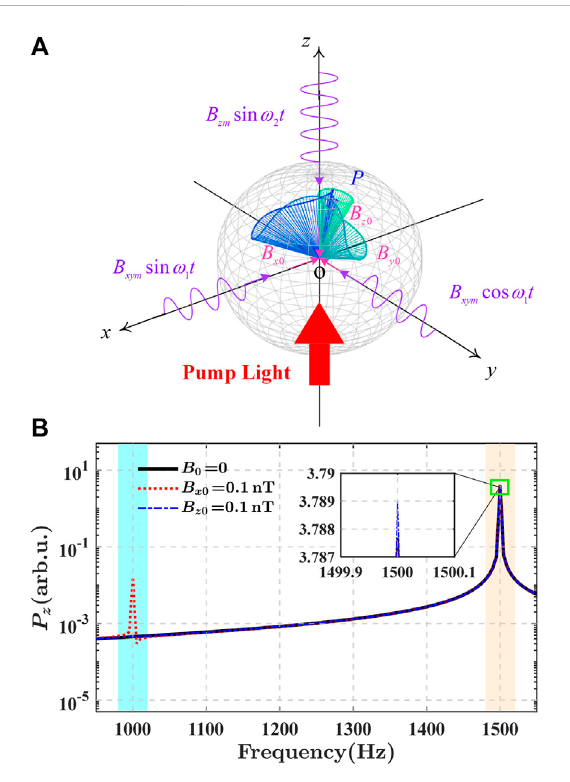
FIGURE 1 Simulation results. (A) The evolution of P subjected to the combinedtriaxialmodulatedmagnetic fi eld.Themeshedsphereis illustrated as a guide for eyes. (B) The frequency-domain response spectrumof P z between800 Hzand1700 Hz.Theblacksolid line represents the condition of B x 0 (cid:1) B y 0 (cid:1) B z 0 (cid:1) 0nT , the red dotted line represents the condition of B x 0 (cid:1) 0 . 1nT and (cid:1) B z (cid:1) 0nT , the blue dot-dashed line represents B y 0 0